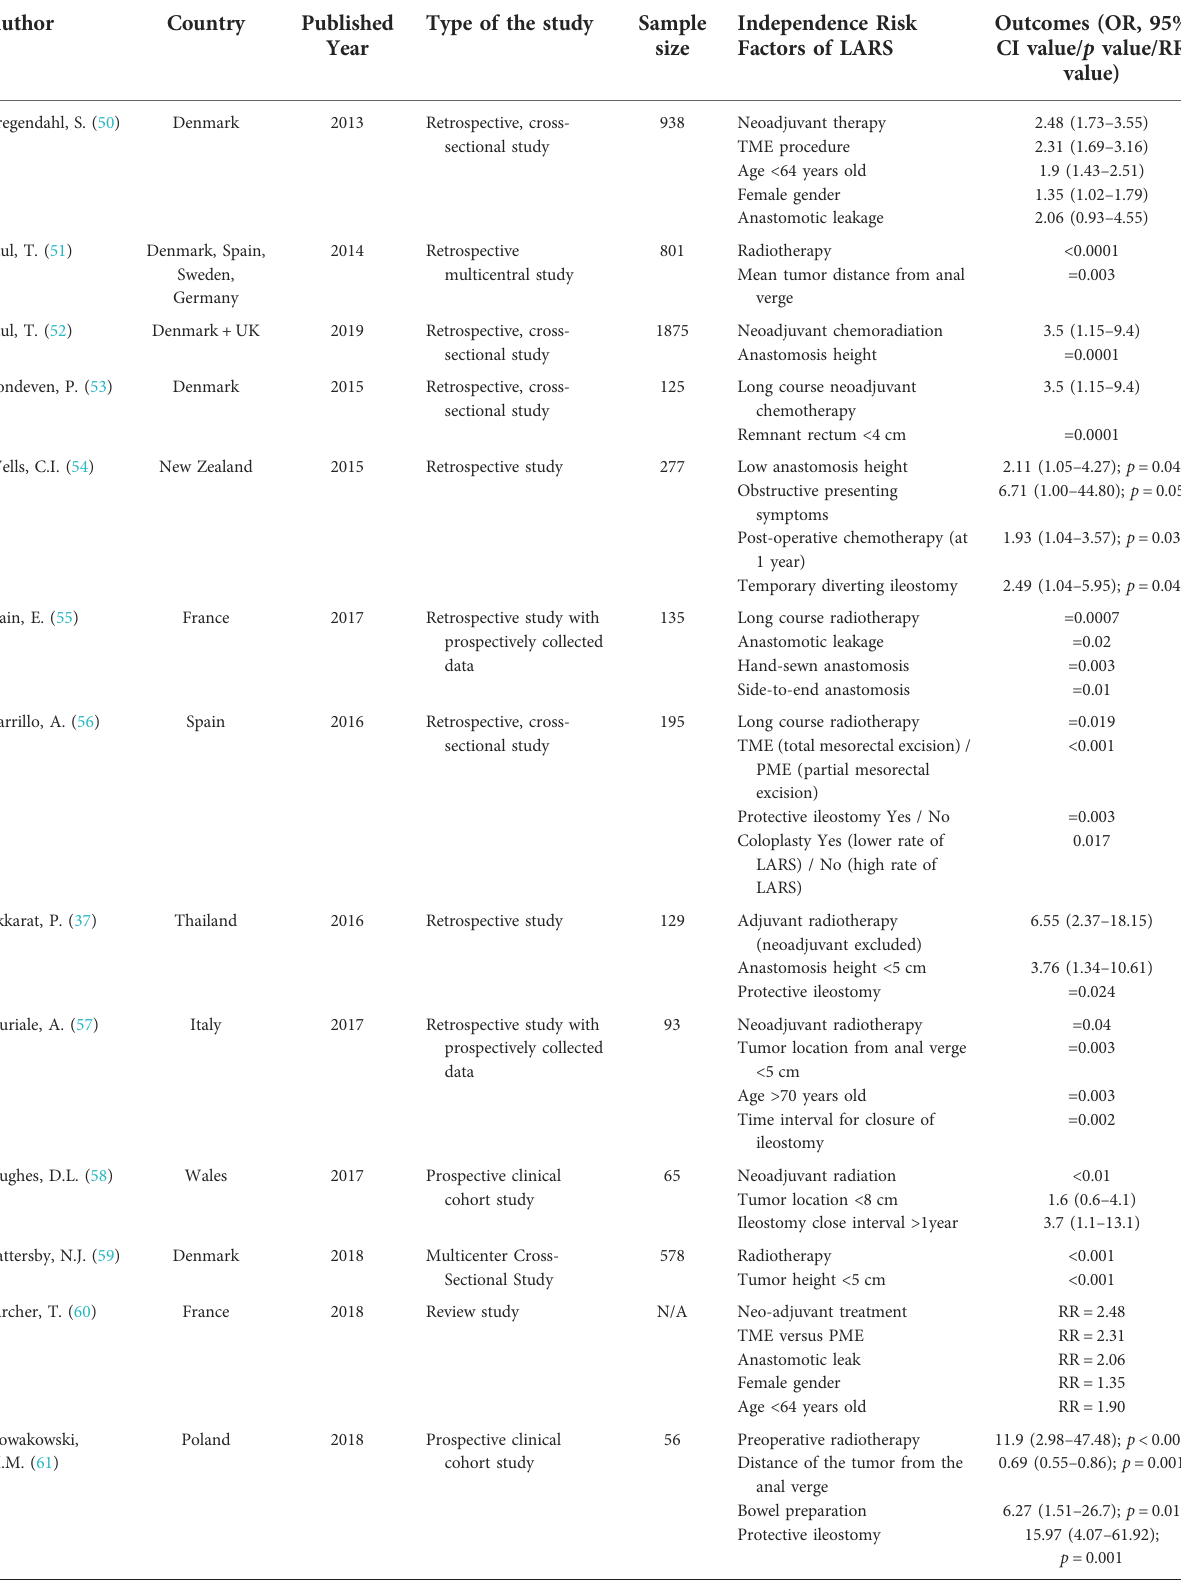
TABLE 5 The independence risk factors of